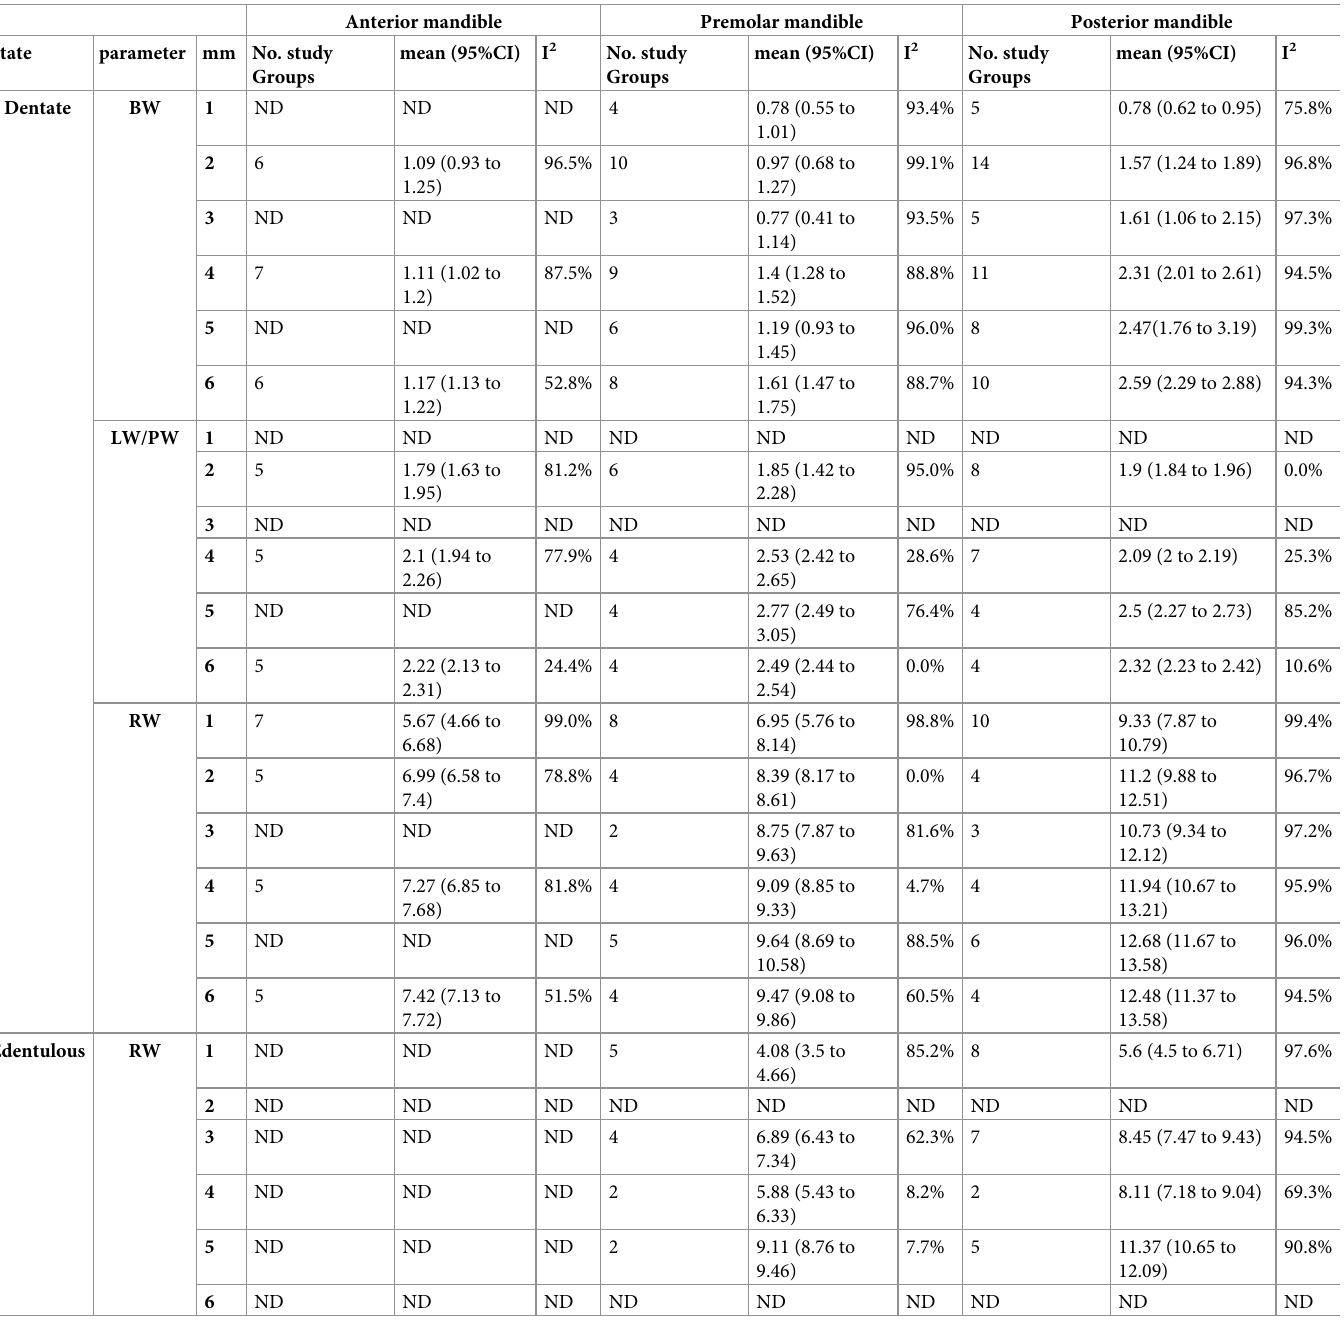
Table 2 for the mandible. The tables present, for each millimeter along the alveolar ridge the number of studies included in the analysis, the calculated combined mean with the 95% confi- dence interval and the consistency (I 2 ). Table 2. Meta-analysis result for the